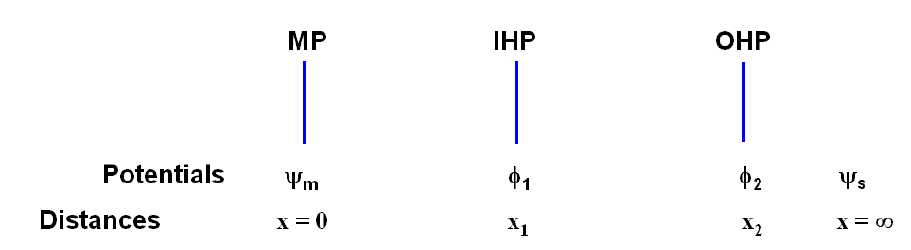
Figure 1. Schematic of the regions considered at the electrode